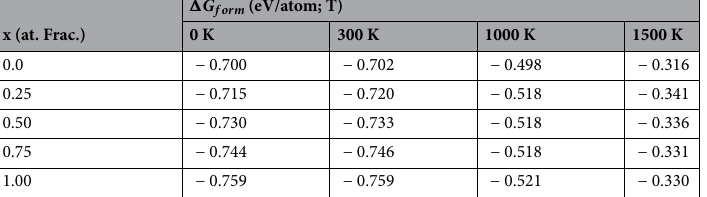
Table 1. The temperature dependent Gibb’s formation enthalpy (E form ) of disorder Ti 2 (Al 1−x Ga x )C MAX phases including the effect of chemical and vibrational entropy included through our machine learning